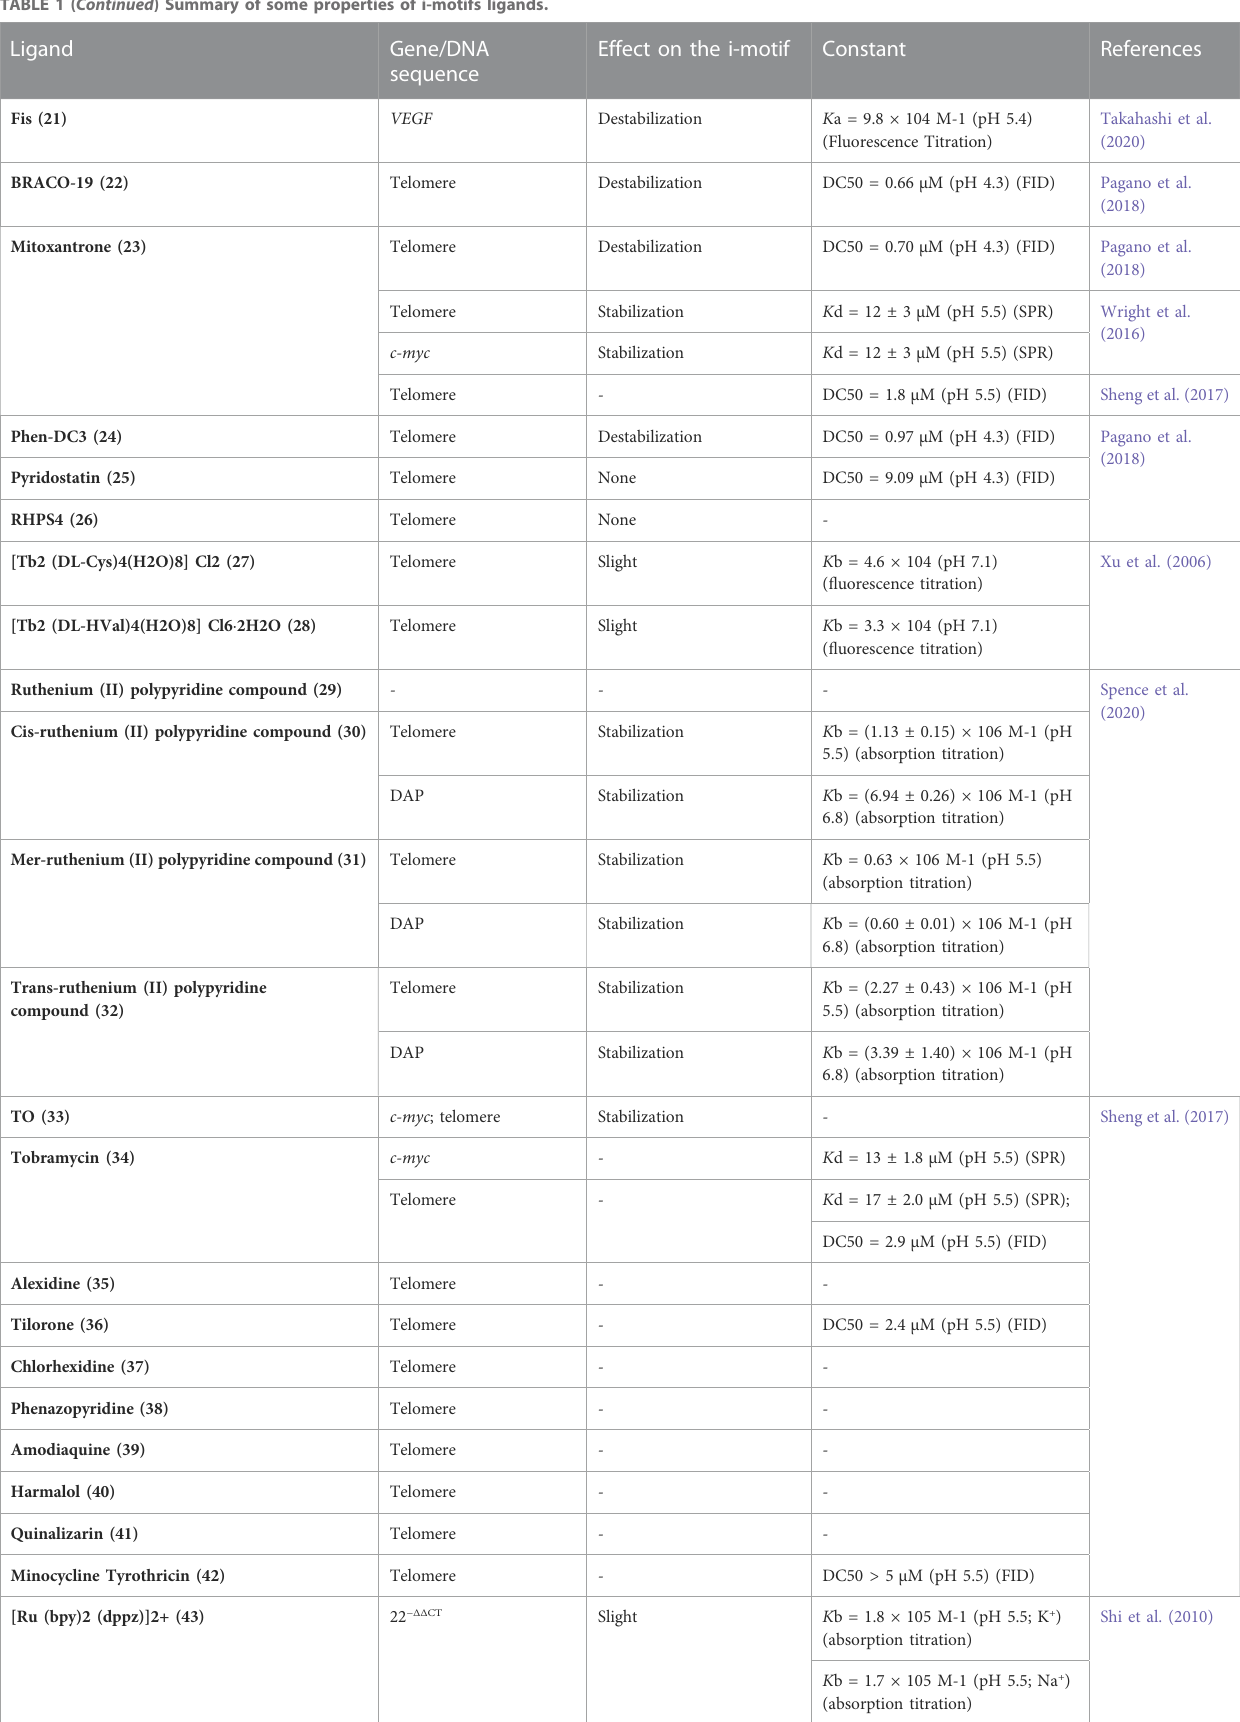
TABLE 1 ( Continued ) Summary of some properties of i-motifs